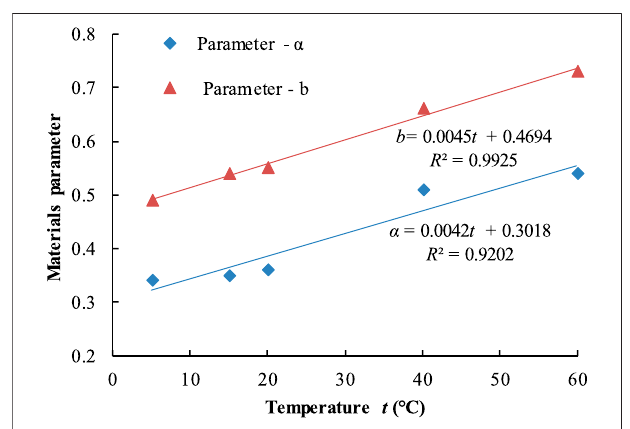
FIGURE 6 | α and b values and fi tting curves at different